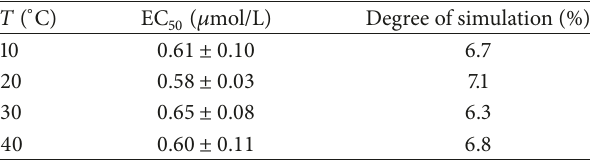
Table 2: EC 50 of FK-Gly at different temperatures.